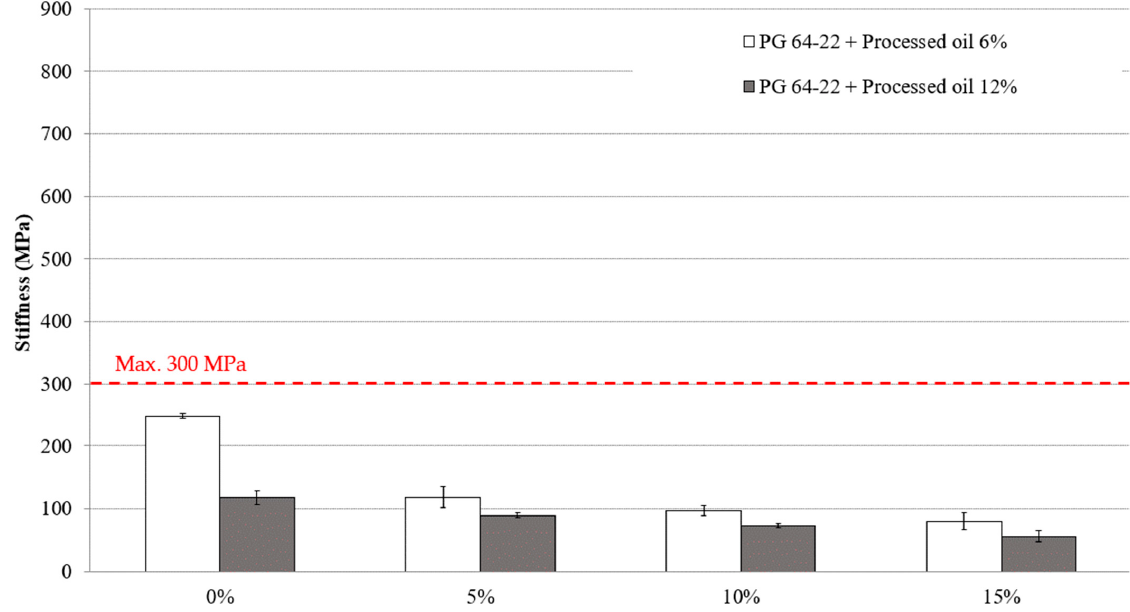
Figure 7. The effects of various CRM contents on the stiffness of RTFO + PAV aged PG 64-22 binder modified with 6% and 12% processed oil at − 12 °C.